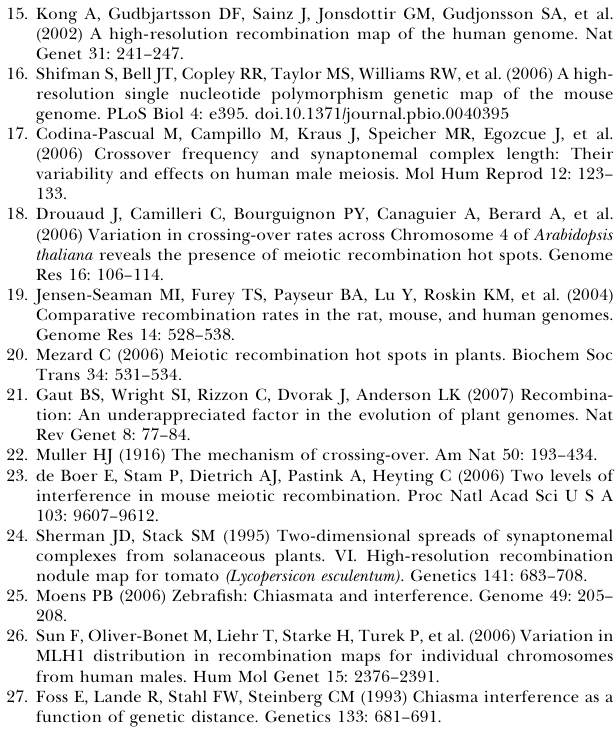
Table S1. List of SNP Markers Used for Genotyping Including Physical Position, 20-bp Left Flanking Sequence, and Alleles Table S2. Physical and Genetic Size of Intervals in Male and Female